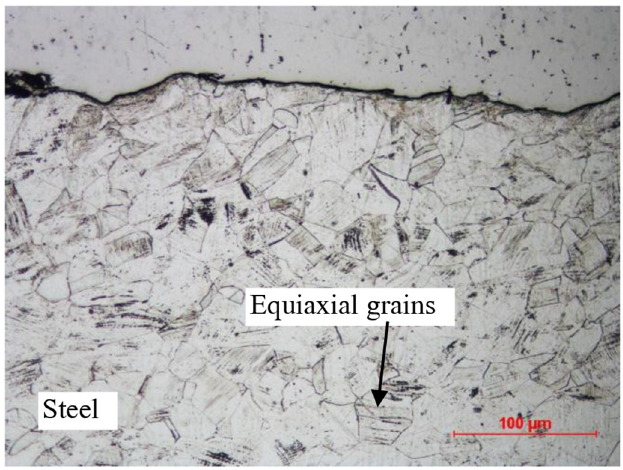
Fig. 4. Microstructure of stainless steel near the bond in specimen after the heat treatment.